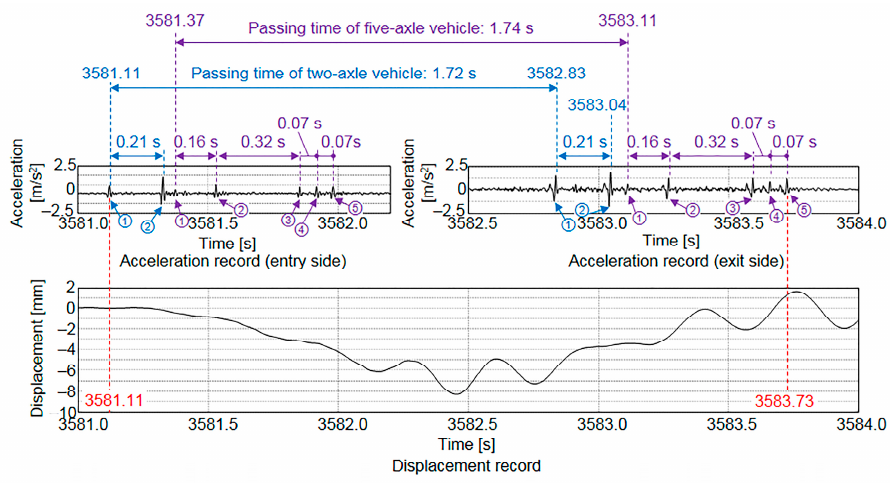
Figure 11. Times of vehicle entry and exit based on acceleration record.